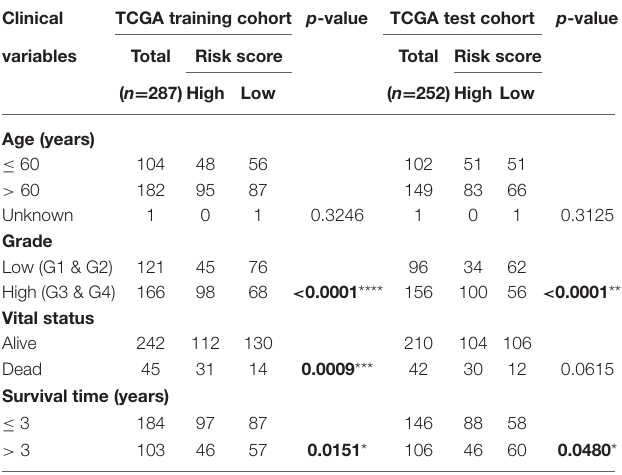
TABLE 2 | Correlation between risk score and clinical variables of patients with EC. Clinical